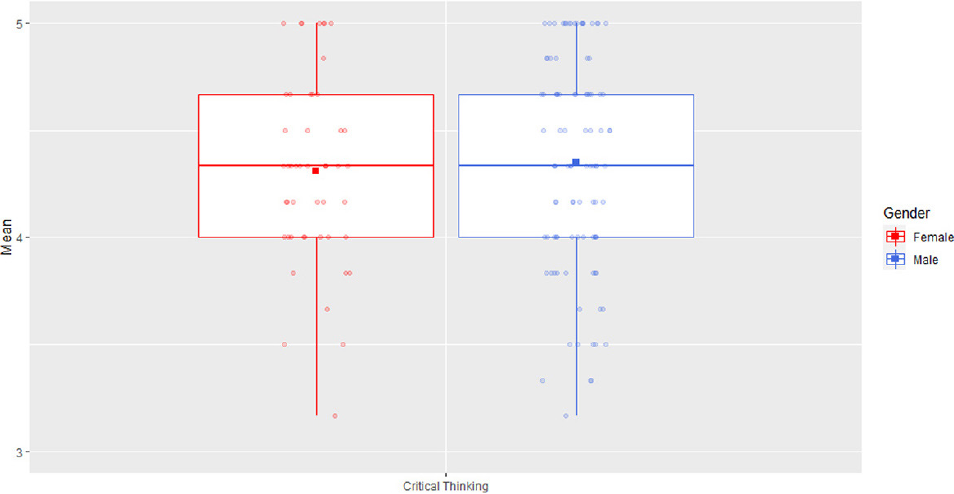
Fig. 6. Boxplot analysis: critical thinking sub-competency by